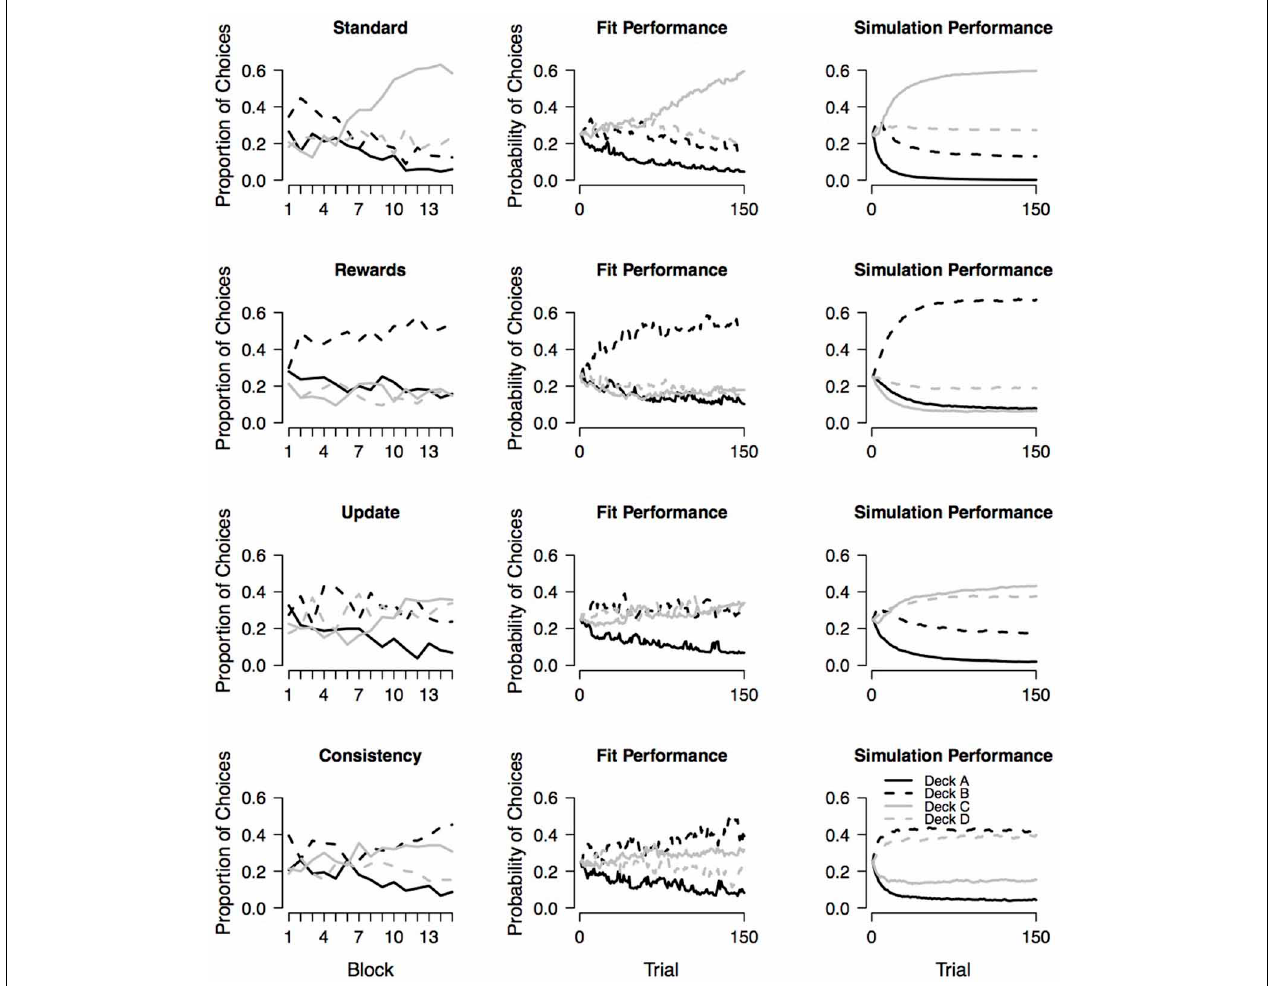
FIGURE A2 | Observed choice behavior and assessment of absolute model performance. The first column shows the mean proportion of choices from each deck within 15 blocks as observed in the four experimental conditions reported by Wetzels et al. (2010). Each block contains 10 trials. The second and third